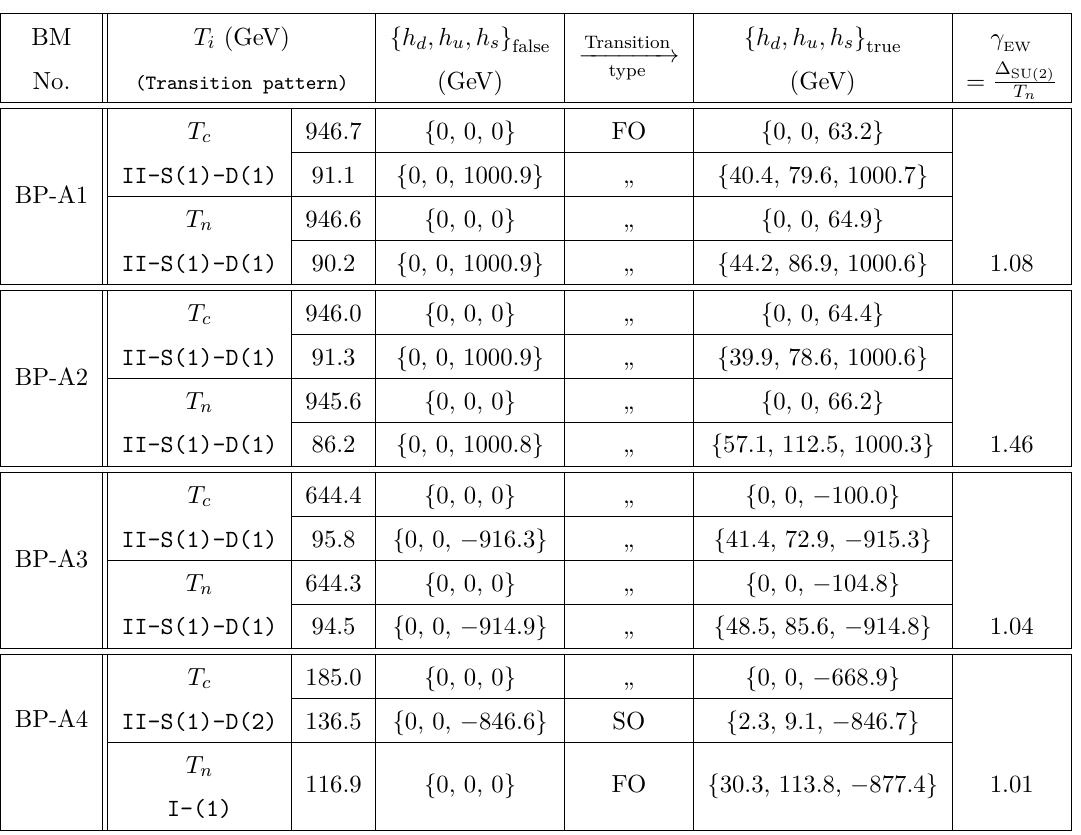
Table 5. Phase transition characteristics of the benchmark points presented in table 4. For each benchmark point, presented are the T ’s and T ’s, the corresponding field values, the transition c n types (‘FO’ for first-order and ‘SO’ for second-order) and the strengths of the phase transition along the SU(2) -direction ( γ ). See text for EW